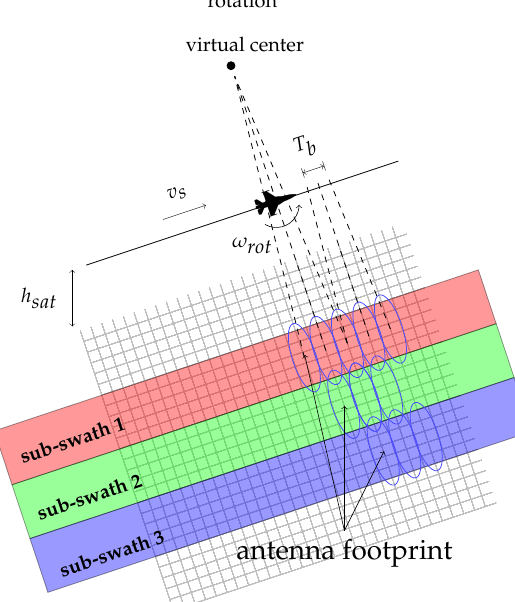
Figure 1. TOPS acquisition mode: the antenna beam has a virtual rotation center located above the platform acquisition track and an angular velocity ω rot . TOPS raw data are acquired in bursts of duration T b , cyclically switching the antenna beam from swath to swath, referred to as sub-swaths, for wide-area coverage. Note also that v s and h sat represent the platform velocity and height,